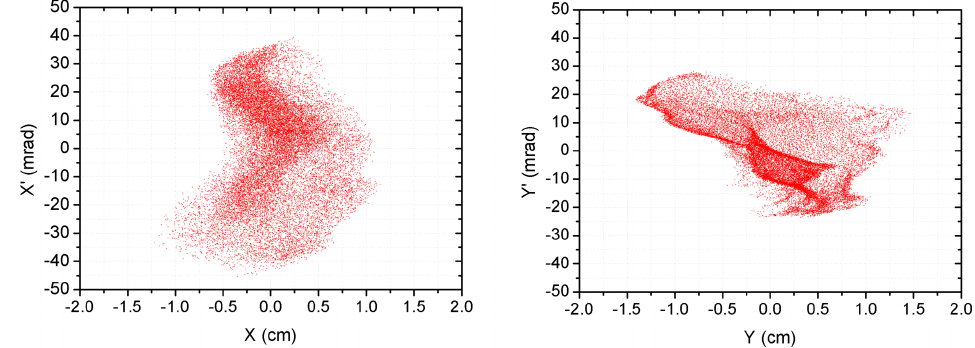
FIG. 16. Simulated phase-space distributions after the CSS using the initial particle distribution obtained from the extraction simulation.